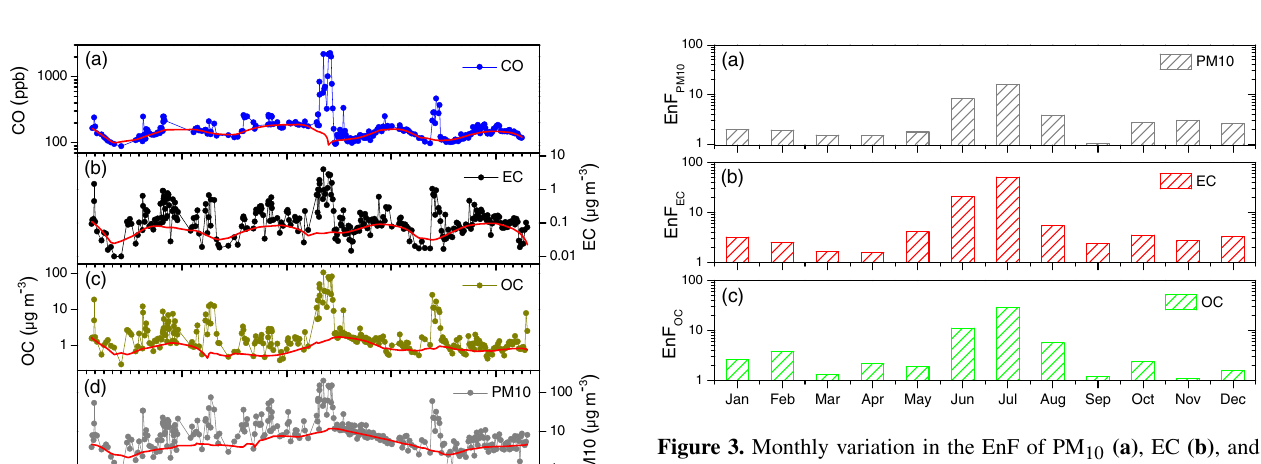
Figure 3. Monthly variation in the EnF of PM 10 (a) , EC (b) , and OC (c) at ZOTTO from April 2010 to June 2014. Kondo et al., 2011a; Wang et al., 2011). Figures 4 and 5 show the seasonal relationships between (cid:49) EC and (cid:49) OC and between (cid:49) EC and (cid:49) CO, respectively. The pollution concen- tration enhancements ( (cid:49) values) were calculated as the